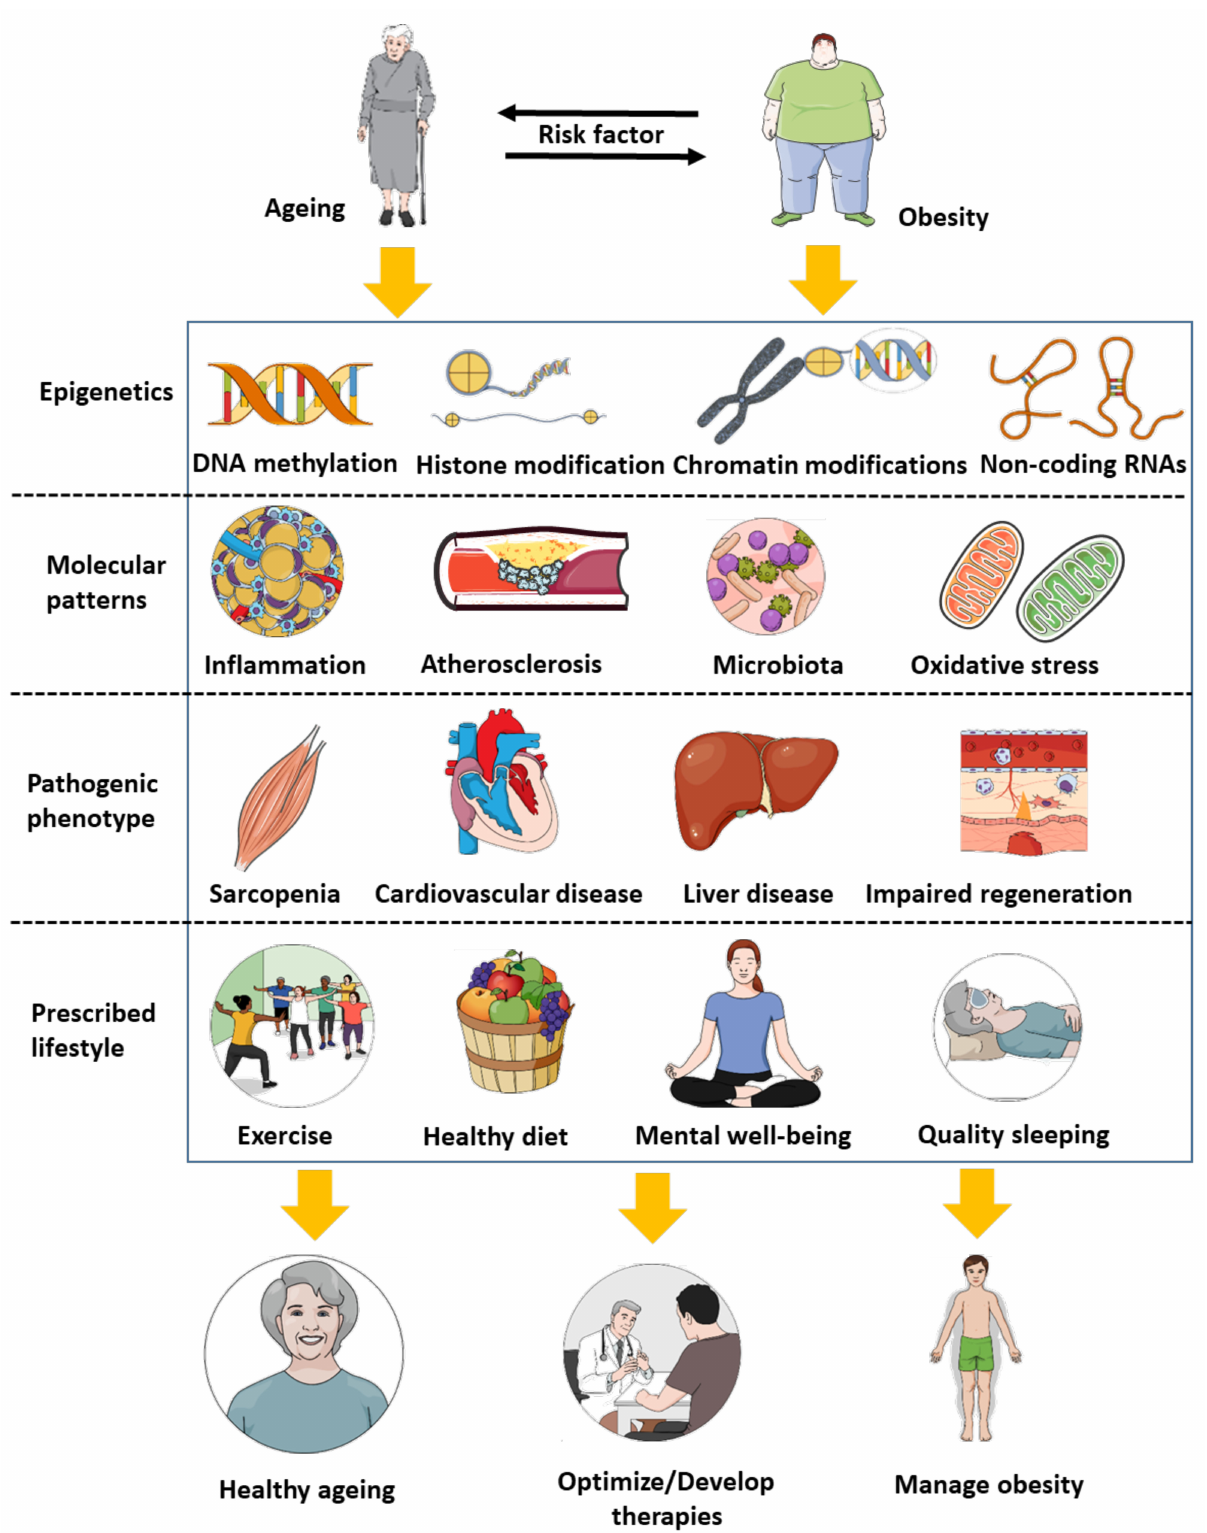
Figure 1. Examples of ageing and obesity shared patterns. Both ageing and obesity represent a risk factor foreach other. Elucidating the patterns shared between ageing and obesity, from epigenetics to molecular pathogenesis, would allow to both optimize healthy ageing and manage